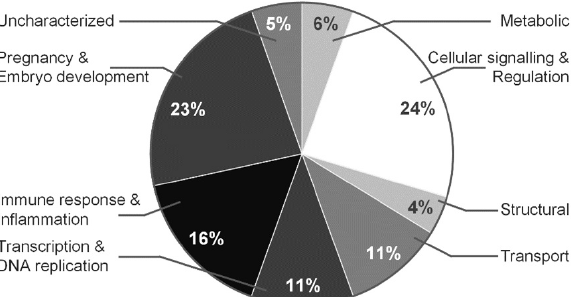
Figure 4. Functions of proteins identified in normal vs. polyhydramnios pregnancies, proteins fractionated in the pI 4–7 range. Proteins were clustered according to their functions by using AgBase [2.00